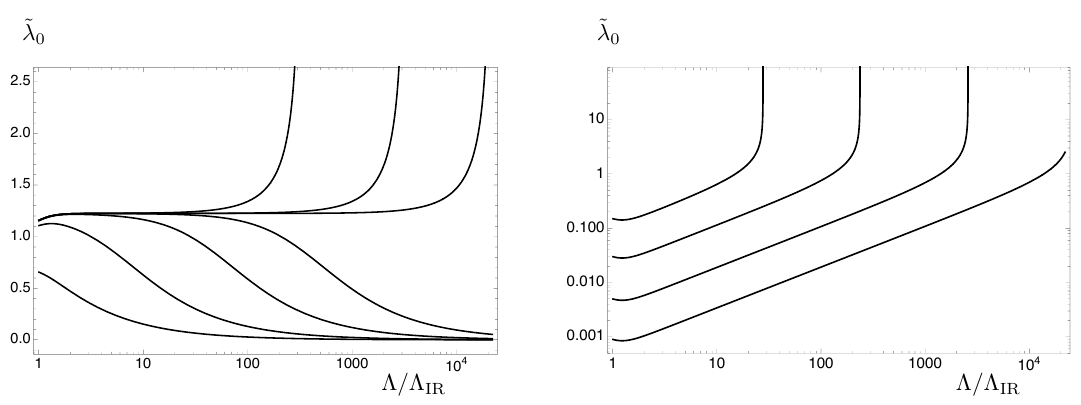
Figure 10 . Model I. The coupling ˜ λ 0 as a function of the energy scale Λ , for ∆ = 2 . 5 and x F = 3 . The two panels show a few possible RG flows for the cases of a relevant deformation with ∆ R = 1 . 75 (left), and an irrelevant deformation with ∆ R = 3 . 25